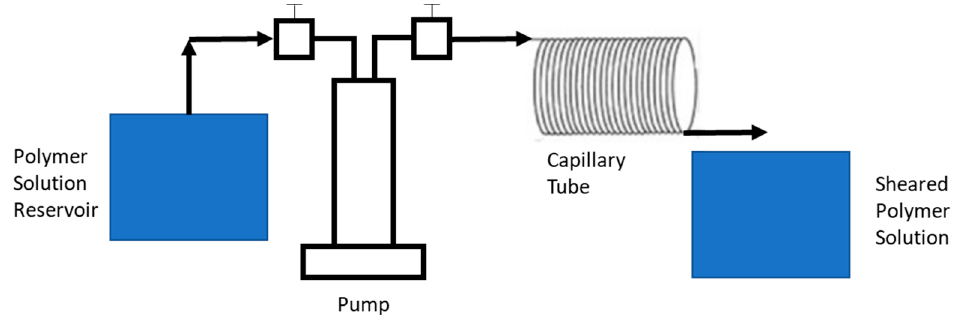
Figure 4. Capillary tube set-up for the determination of mechanical degradation (adapted from [12]). Wei et al. [12] calculated the mechanical degradation of each polymer sample (viscosity loss) from viscosity measurements at a shear rate of 6 s − 1 , which is similar to the “degree of degradation” calculation reported by Zaitoun et al. [27].